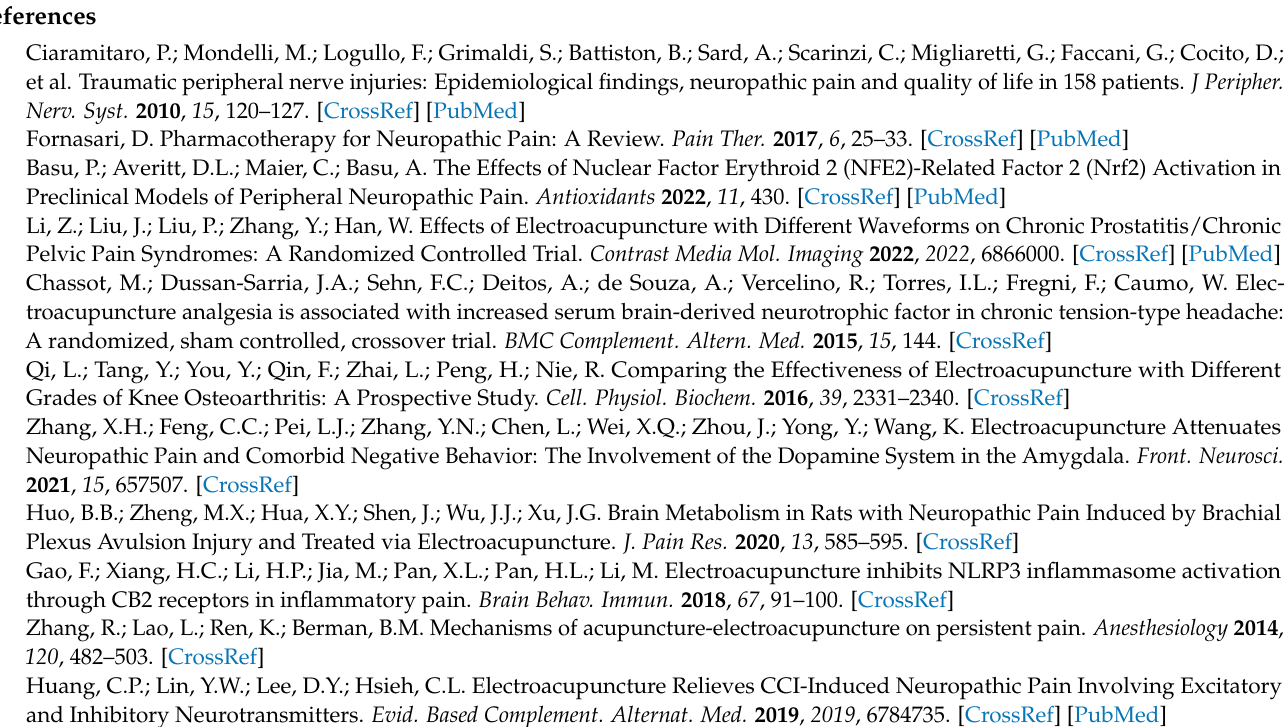
cent images; Figure S2: Brain Region S1 (Contralateral); Figure S3: Brain Region S1 (Contralateral); Figure S4: Brain Region S1 (Contralateral); Figure S5: Brain Region S1 (Ipsilateral); Figure S6: Brain Region S1 (Ipsilateral); Figure S7: Brain Region ACC (contralateral); Figure S8: Brain Region ACC (contralateral); Table S1: S1(contralateral)_TNI vs Sham; Table S2: S1(contralateral)_TNI-EA vs TNI; Table S3: S1(ipsilateral)_TNI vs Sham; Table S4: S1(ipsilateral)_TNI-EA vs TNI; Table